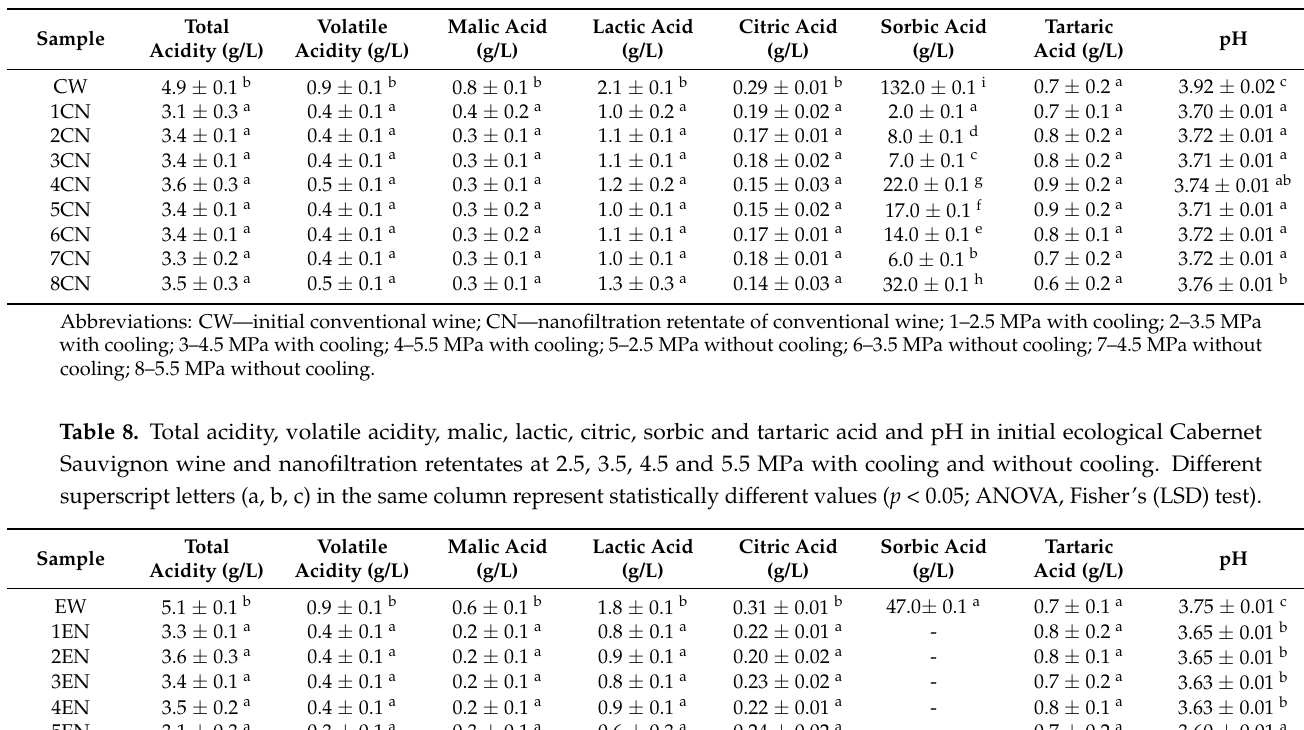
Table 7. Total acidity, volatile acidity, malic, lactic, citric, sorbic and tartaric acid and pH in initial conventional Cabernet Sauvignon wine and nanofiltration retentates at 2.5, 3.5, 4.5 and 5.5 MPa with cooling and without cooling. Different superscript letters (a, b, c, d, e, f, g, h, i) in the same column represent statistically different values ( p < 0.05; ANOVA, Fisher’s (LSD) test).